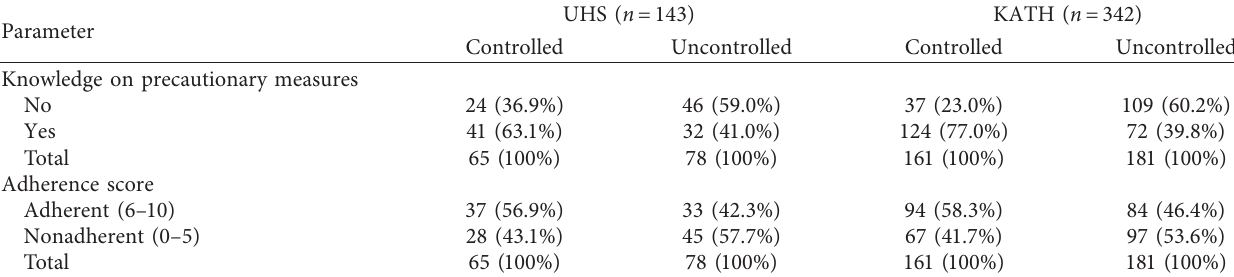
Table 5: Effect of knowledge and adherence on blood pressure control.